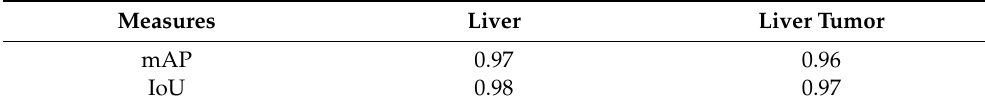
Table 6. Localization results.